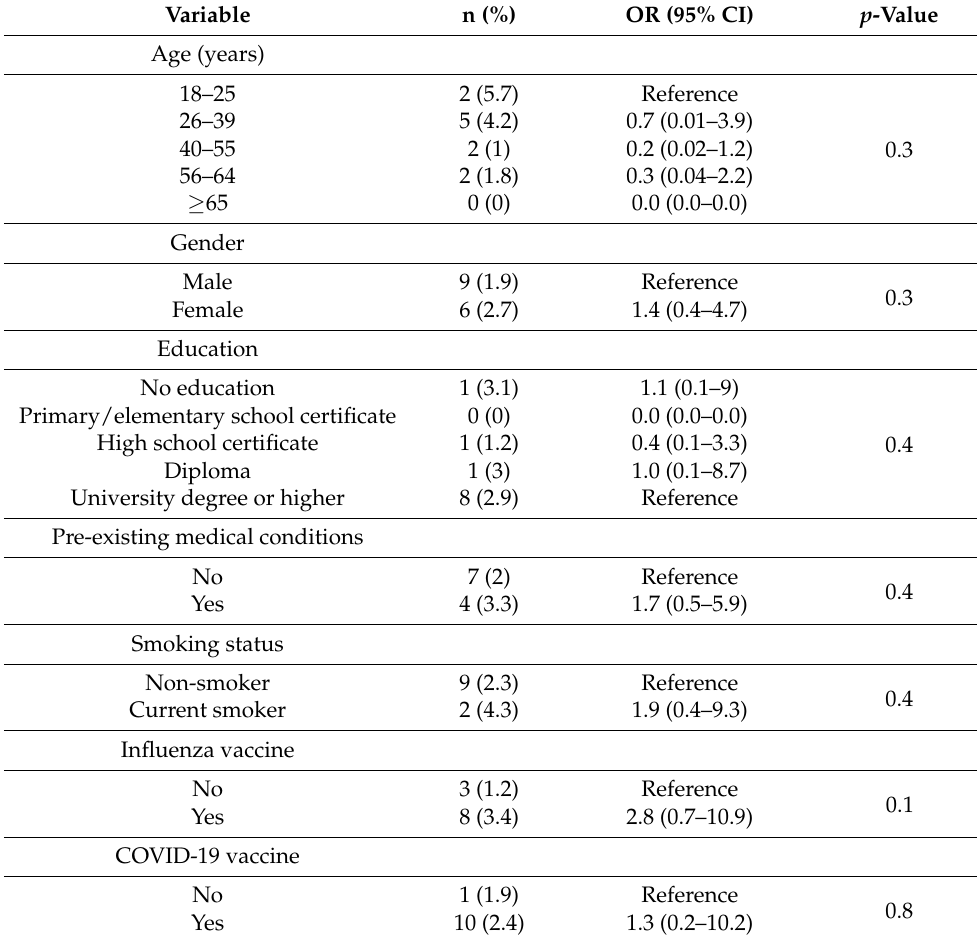
Table 4. Associations of potential factors with respiratory tract infections among participants (n =